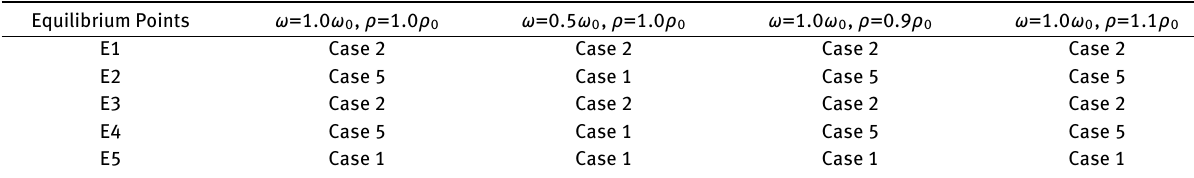
Table 3. Topological cases of the equilibrium points around 22 Kalliope with different parameters Equilibrium